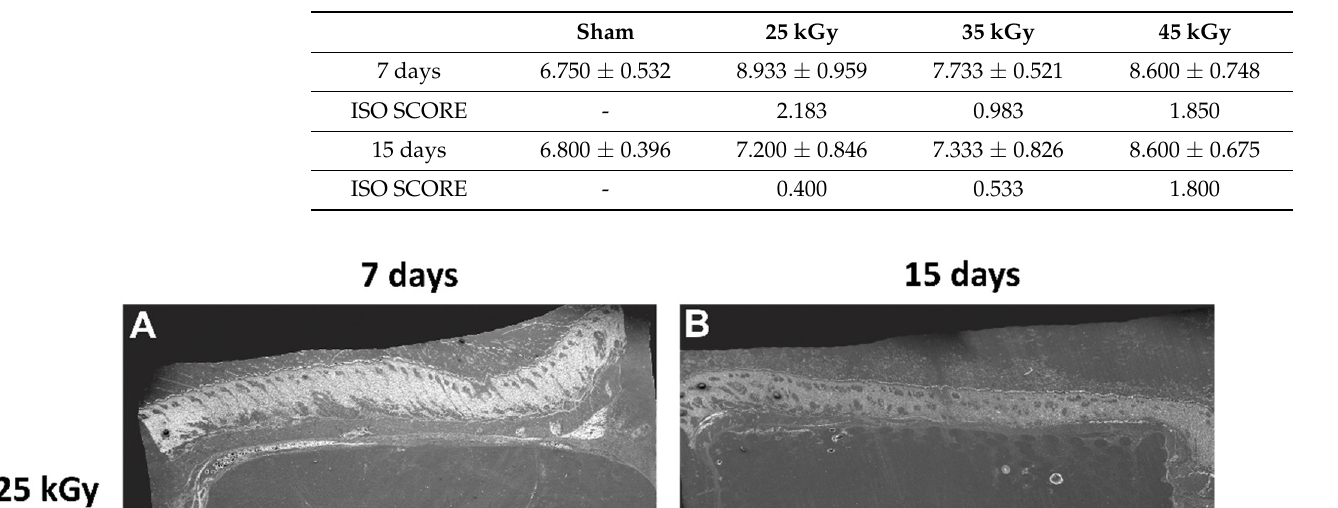
Table 2. Global histological scores presented as mean ± SE following ISO-10993-6 guidelines for the PCL devices groups and sham, at 7 and 15 days after implantation.